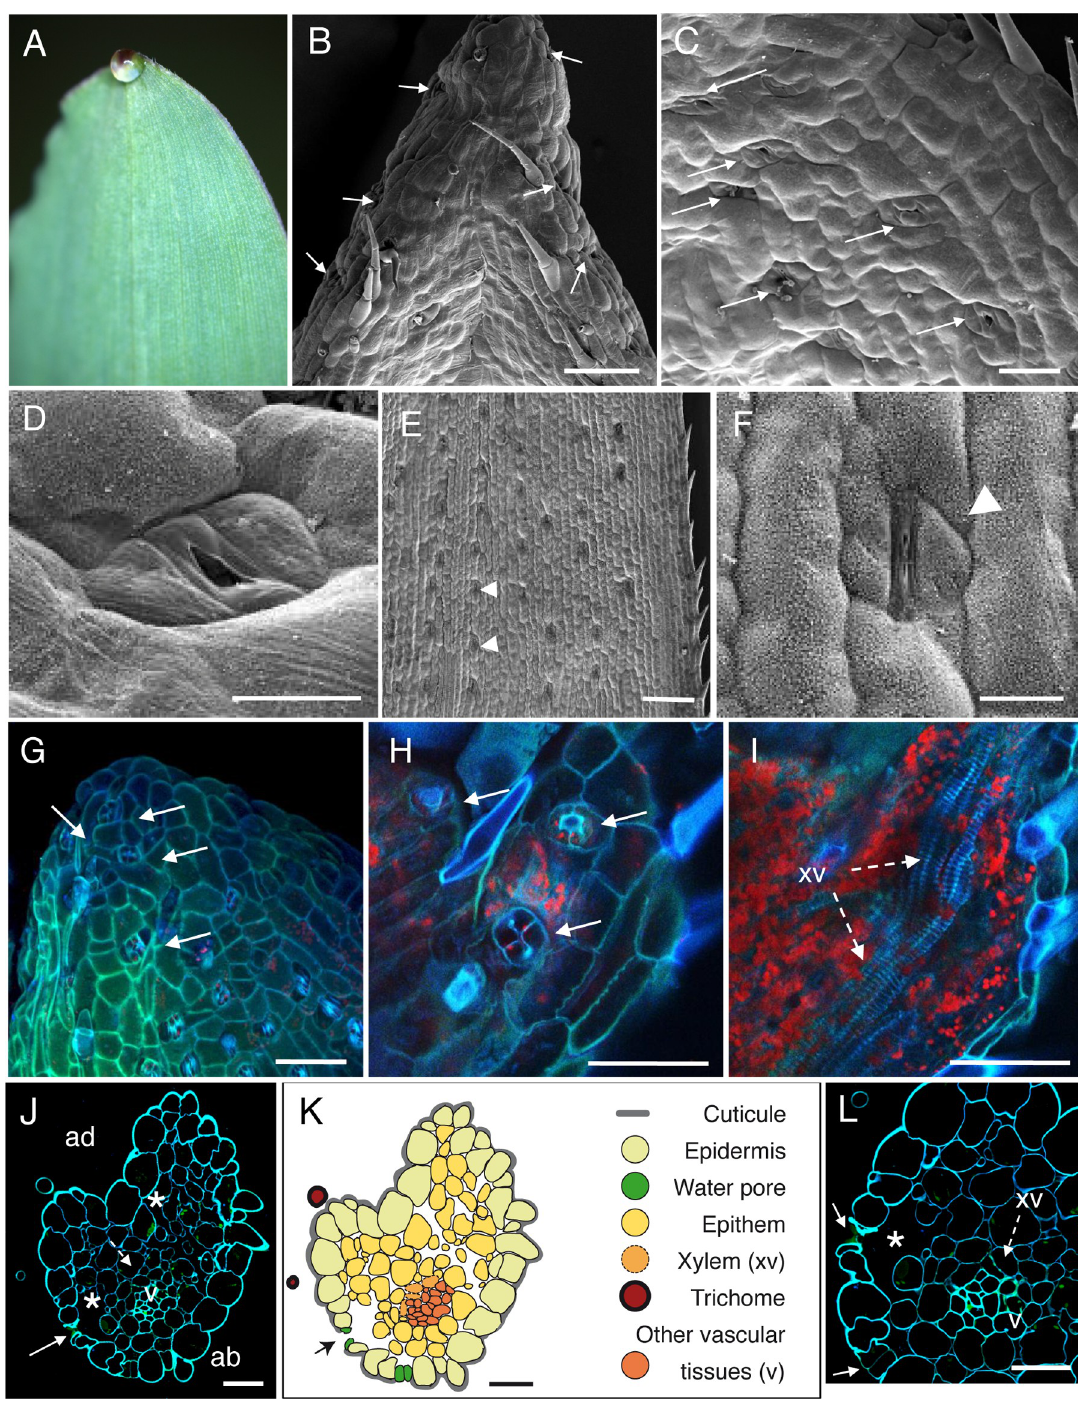
Fig 1. Anatomic description of maize apical hydathodes by confocal and Scanning Electron Microscopy (SEM). (A) A guttation droplet at the leaf tip. (B-D) The adaxial face of leaf tip was imaged by SEM. Water pores are observed in the gutter. (E-F) Observations of stomata were performed on distal parts of leaves relative to panels B-D. Panel F is a closeup image of panel E. (G-I) Confocal images of fresh adaxial face of the leaf tip. (G) The image is a maximal projection of 50 confocal planes in z dimension (1- μ m steps). (H-I) Observations in z axis of the same sample at the epidermal level (H) and below the epidermal layer (I). Each overlay image corresponds to the maximal projection of 25–30 confocal planes acquired in z dimension. (J, L) Transversal sections (1- μ m thickness) of fixed tissue at 80–100 μ m from the tip were observed by confocal microscopy. White arrows, arrowheads, dashed arrows and asterisks indicate water